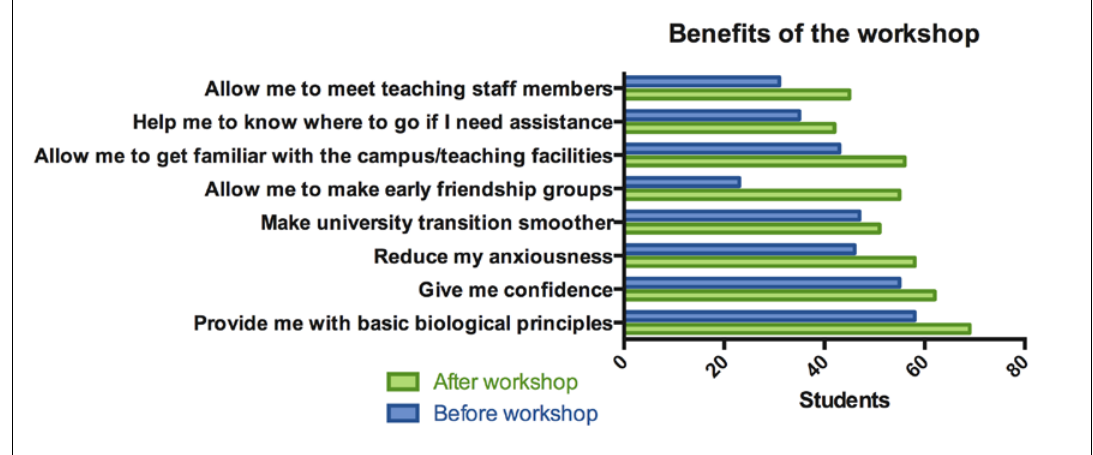
Figure 4: Number of students agreeing with the suggested benefits